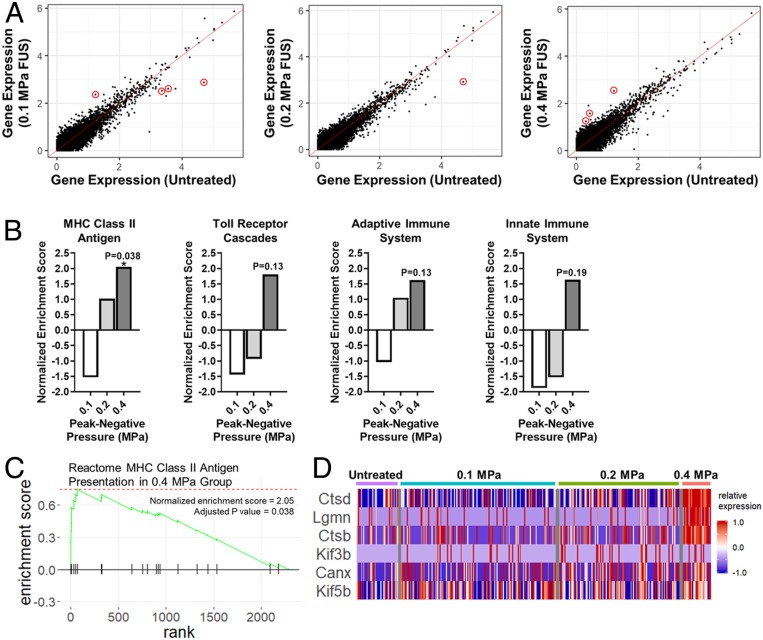
Single-cell RNA sequencing analyses indicate that sonoselective transfection with low-pressure FUS does not significantly affect the transcriptome of brain capillary endothelial cells in vivo. (A) Expression of individual genes in mRUBY+ endothelial cells transfected with 0.1-, 0.2-, and 0.4-MPa FUS in comparison to the expression of the same genes in untreated endothelial cells. Only eight total transcripts were differentially expressed (P < 0.05; red circles). (B) Selected gene-set enrichment analyses for mRUBY+ endothelial cells. While some gene sets associated with inflammation approached significance in the 0.4-MPa group, only the MHC Class II Antigen Presentation gene set was significantly enriched compared to untreated endothelium. (C) Enrichment plot for the MHC Class II Antigen Presentation gene set. (D) Leading-edge analysis of the MHC Class II Antigen Presentation gene set, showing that the Ctsd, Lgmn, and Ctsb transcripts predominantly drive enrichment of this gene set at 0.4 MPa.